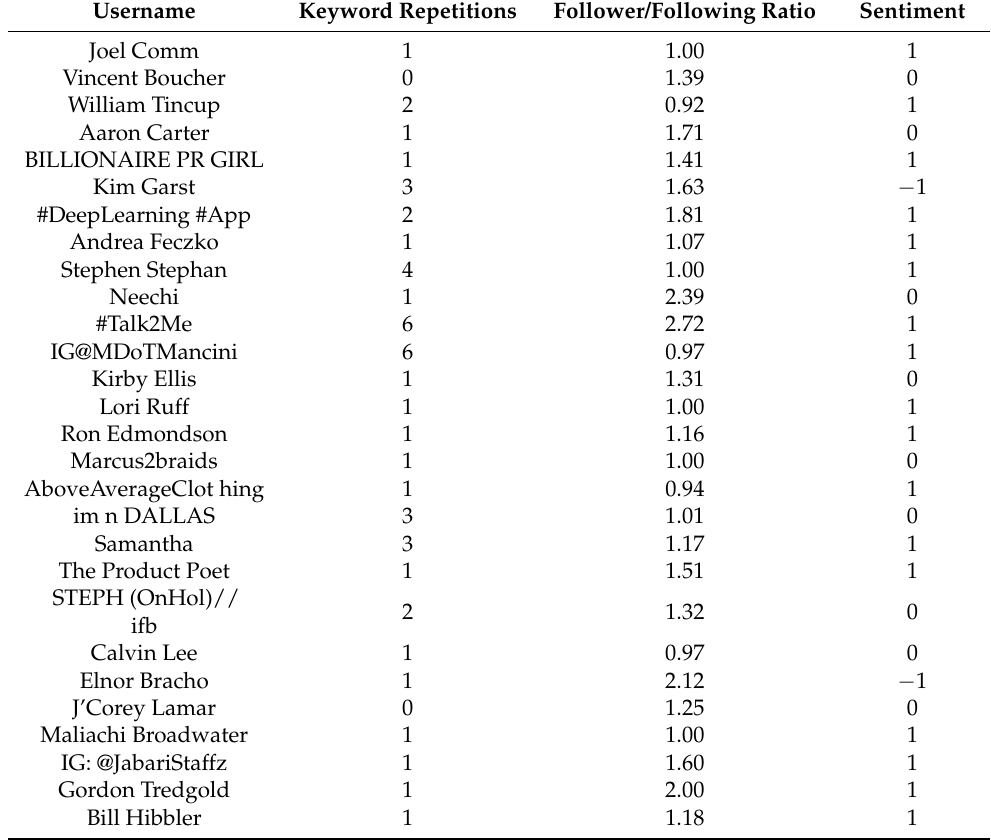
Table 7. Result of proposed method on Apple event